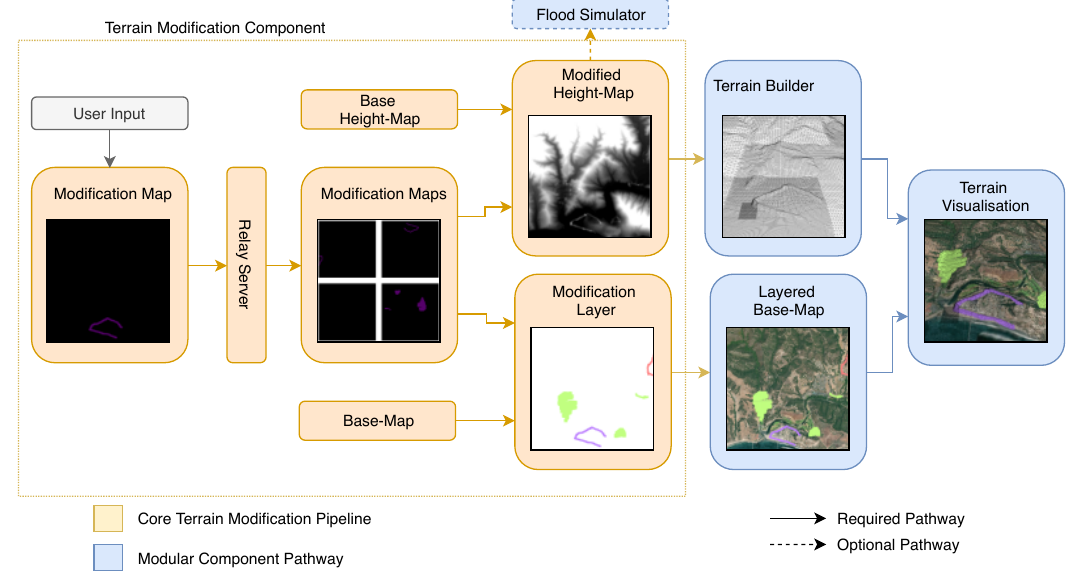
Figure 3. The Terrain Modification pipeline. The Terrain Modification component augments both the base height map and the base map to create an annotated and modified terrain, synced with all users using the relay